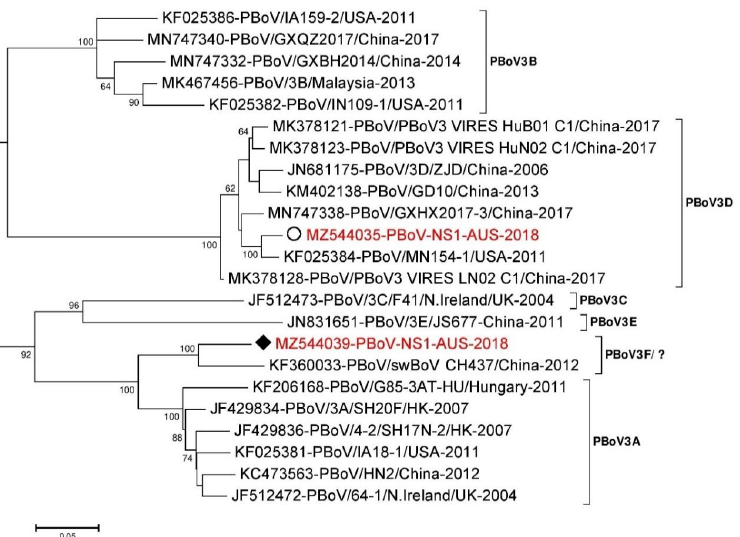
Figure 3. Phylogenetic analysis of the partial nucleotide sequences from the NS1 region of PBoV3. The nucleotide sequences were aligned and analysed using the maximum likelihood method in MEGA 7.0 [63] using the Hasegawa–Kishino–Yano (HKY + G + I) [84] model with a bootstrapping of 1000 replicates. The analysis included 21 reference sequences of the NS1 non-structural region of PBoV3 genome and two PBoV3 sequences from this study. The numbers at nodes represent bootstrap values and values above 60% are shown. Branch lengths are scaled according to the numbers of nucleotide substitutions per site. The sequence name indicated in red colour from Pig 45 lung sample has been labelled with a white circle ( ⭘ ) while the Pig 46 colon sample has been labelled with a black rhombus ( ♦